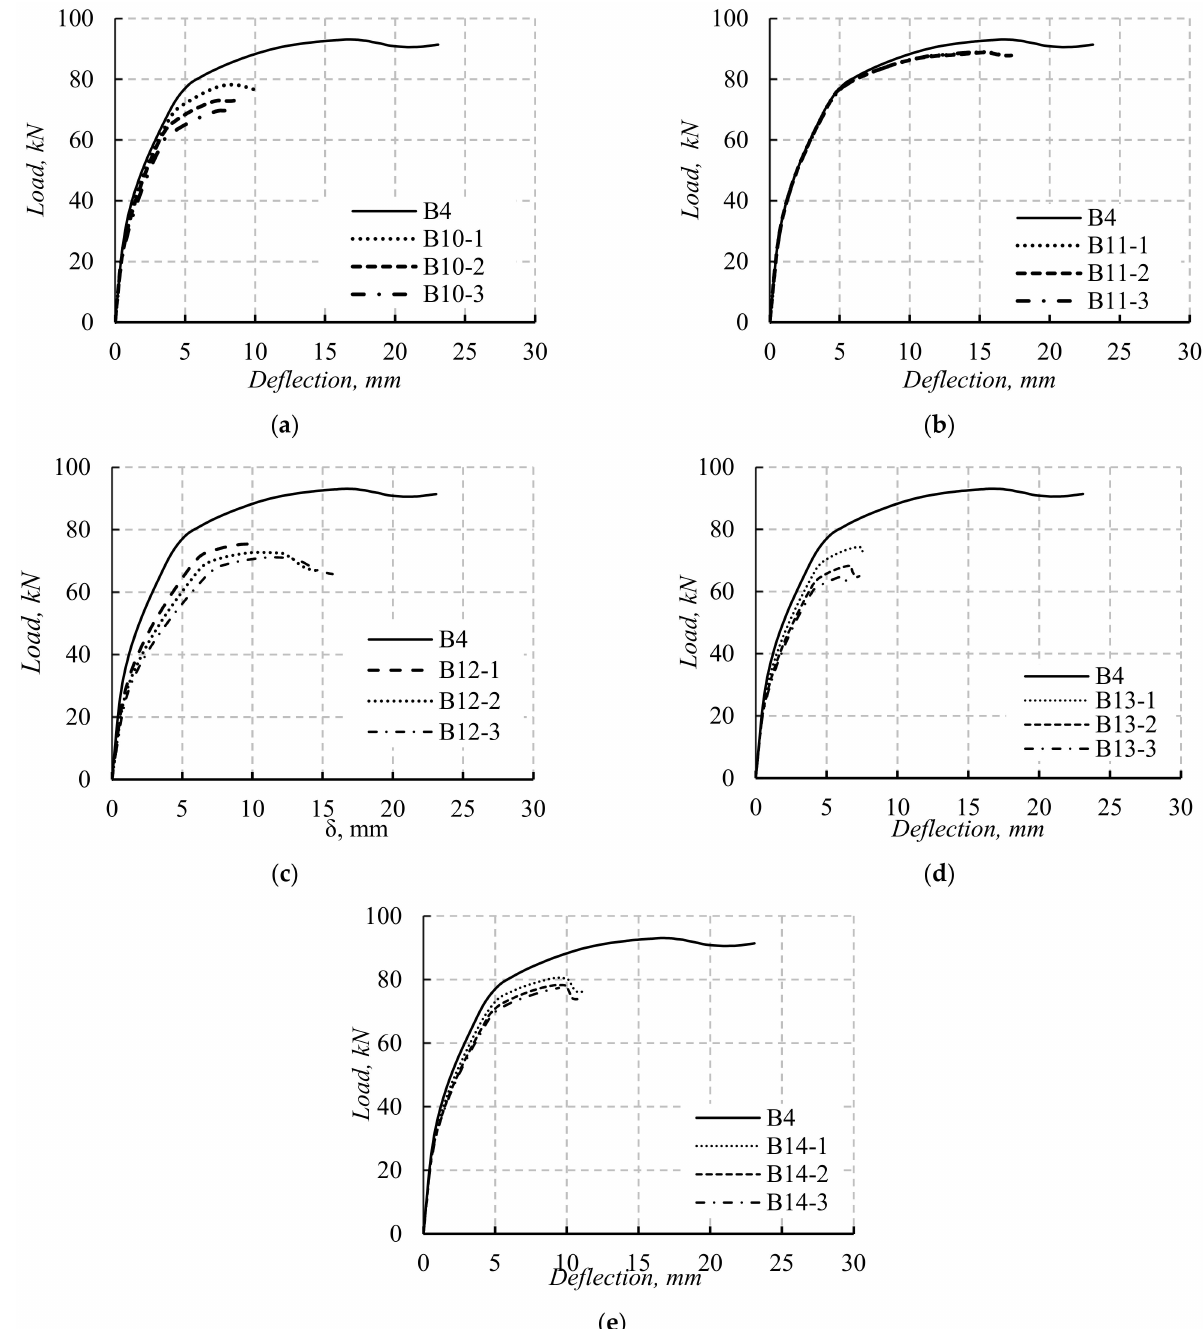
Figure 14. The P – δ curves of the simulated beams with L = 2200 mm: ( a ) beams with TNCH; ( b ) beams with TNSH; ( c ) beams with LH; ( d ) beams with LH and TNCH; ( e ) beams with LH and